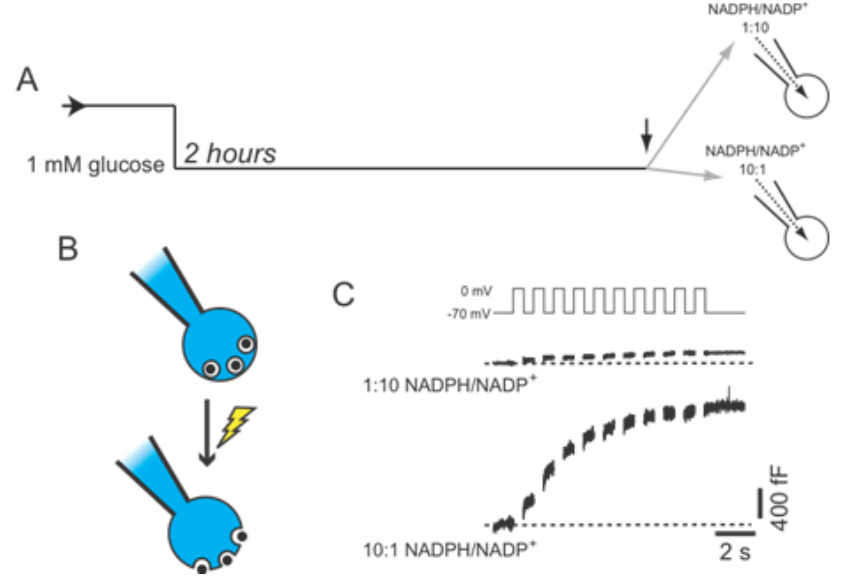
Figure 3. Amplification of β-cell exocytosis by NADPH. ( A ) Mouse β-cells were maintained at a non-stimulatory glucose concentration (1 mM) for 2 hours prior to intracellular dialysis of NADPH/NADP + (at molar ratios of either 1:10 or 10:1) and whole-cell patch-clamp measurement of exocytosis; ( B ) Exocytosis is measured as the increase of cell surface area (capacitance) that occurs following membrane depolarization, opening of voltage-dependent Ca 2+ channels, and subsequent fusion of secretory granules with the plasma membrane; ( C ) The exocytotic response to a series of ten membrane depolarizations remained low under the reduced NADPH condition (1:10), but is significantly amplified by elevation of NADPH (10:1) even when glucose remains low (1